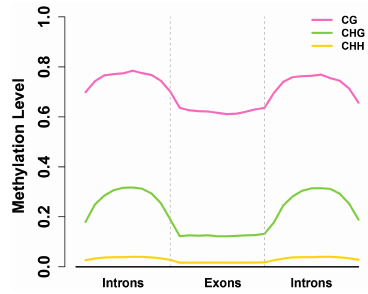
Figure 5. Methylation levels across exons and introns. Only internal exons